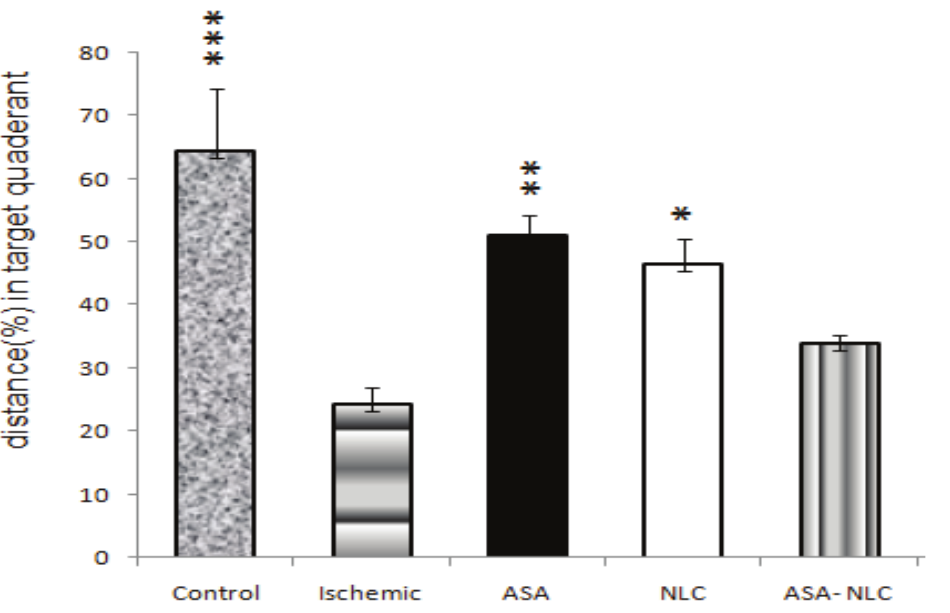
Figure 2: In the ischemic group, the percentage distance spent at target quadrant, was significantly less than that of the control group. Animals in ASA and NLC groups spent significantly more time in target quadrant compared with the ischemic group. Data are expressed as